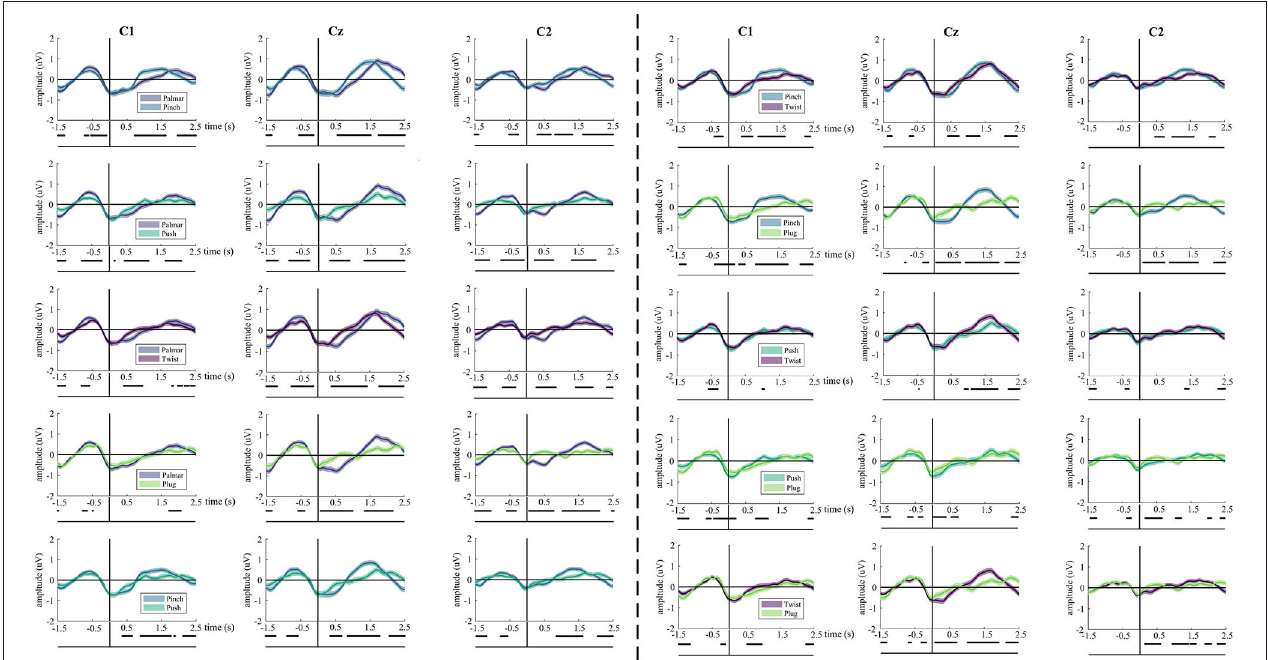
FIGURE 3 | The grand average of all trials of MRCPs for every pair of grasps. Grand average (bold lines) and 95% confidence intervals (shaped areas) for all grasp conditions and the no-movement condition of C1, Cz, and C2. Time = 0s denotes the starting point of movement. Below the axis, we marked significantly different ( p < 0.05) timepoints resulting from the Wilcoxon rank sum test for each grasp-vs.-grasp